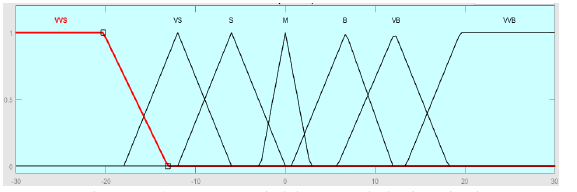
Fig.17: Output variable: Modulation index